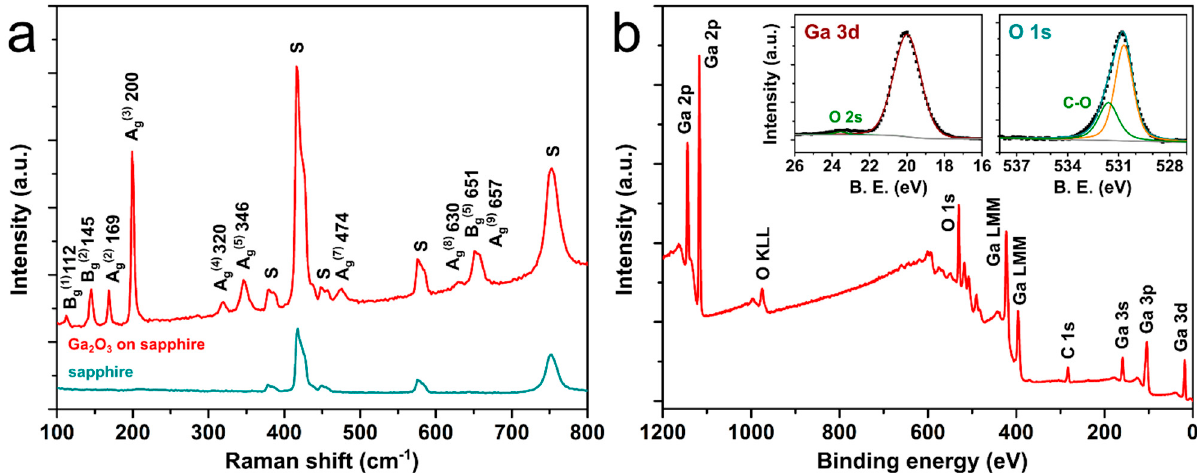
Figure 4. ( a ) A typical micro-Raman spectrum of as-grown Ga 2 O 3 thin films, the phonon modes and their respective values in cm − 1 are indicated above each peak. The sapphire substrate spectrum is shown for comparison, its Raman peaks are marked with ‘S’. ( b ) A typical XPS survey spectrum of as-grown Ga 2 O 3 thin films. The insets show individual Ga 3d and O 1s peak scans. All the prepared samples gave qualitatively similar results.